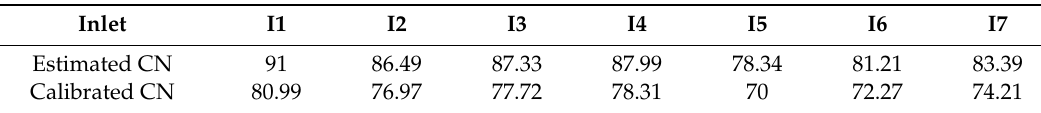
Table 3. Curve numbers of the different subbasins draining to the Inverness pond inlets.